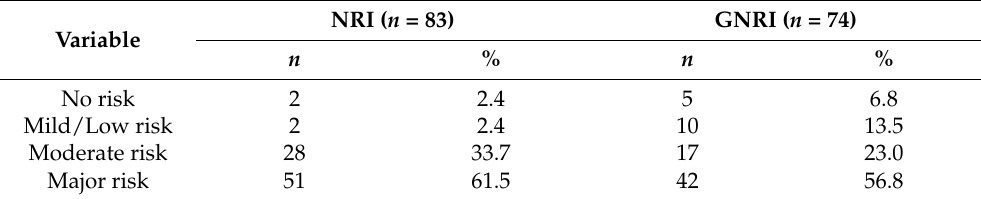
Table 2. Summarize of NRI and GNRI results.